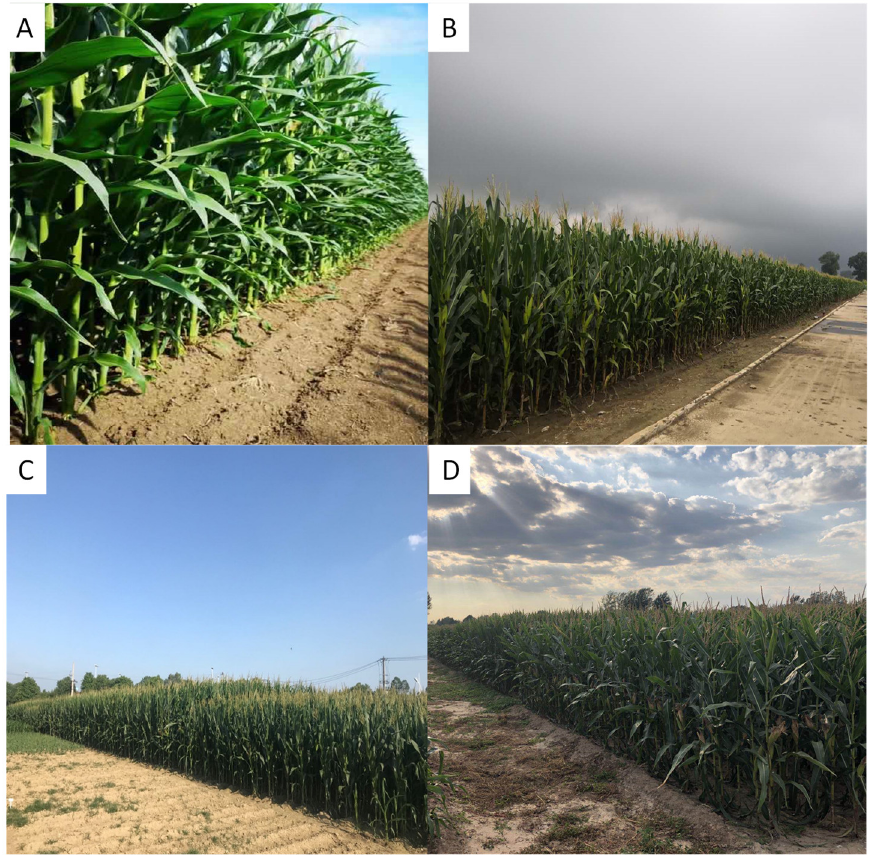
Figure 2. The images of maize growing in the fields at some of the experimental sites in different regions. ( A ) Qitai in NW. ( B ) Jiling in NM. ( C ) Mianyang in SW. ( D ) Xinxiang in HM.